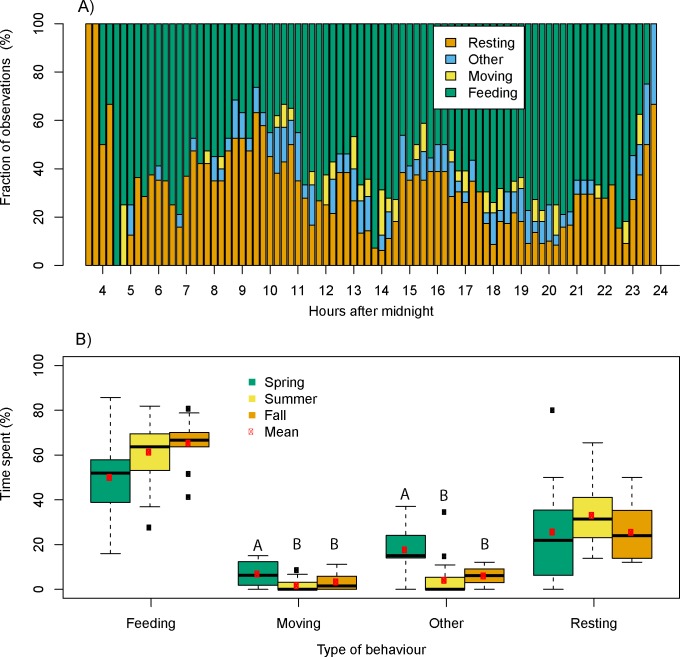
Daily and seasonal behavioural patterns.Fraction of observations where the bison herd rest, feed, move or express other types of behaviour during a day throughout the observation period (spring, summer and autumn) (A). Time spent on a specific type of behaviour across the seasons (spring, summer, and autumn) (B). Different letters are attributed to seasons that vary significantly from other seasons within the same type of behaviour.